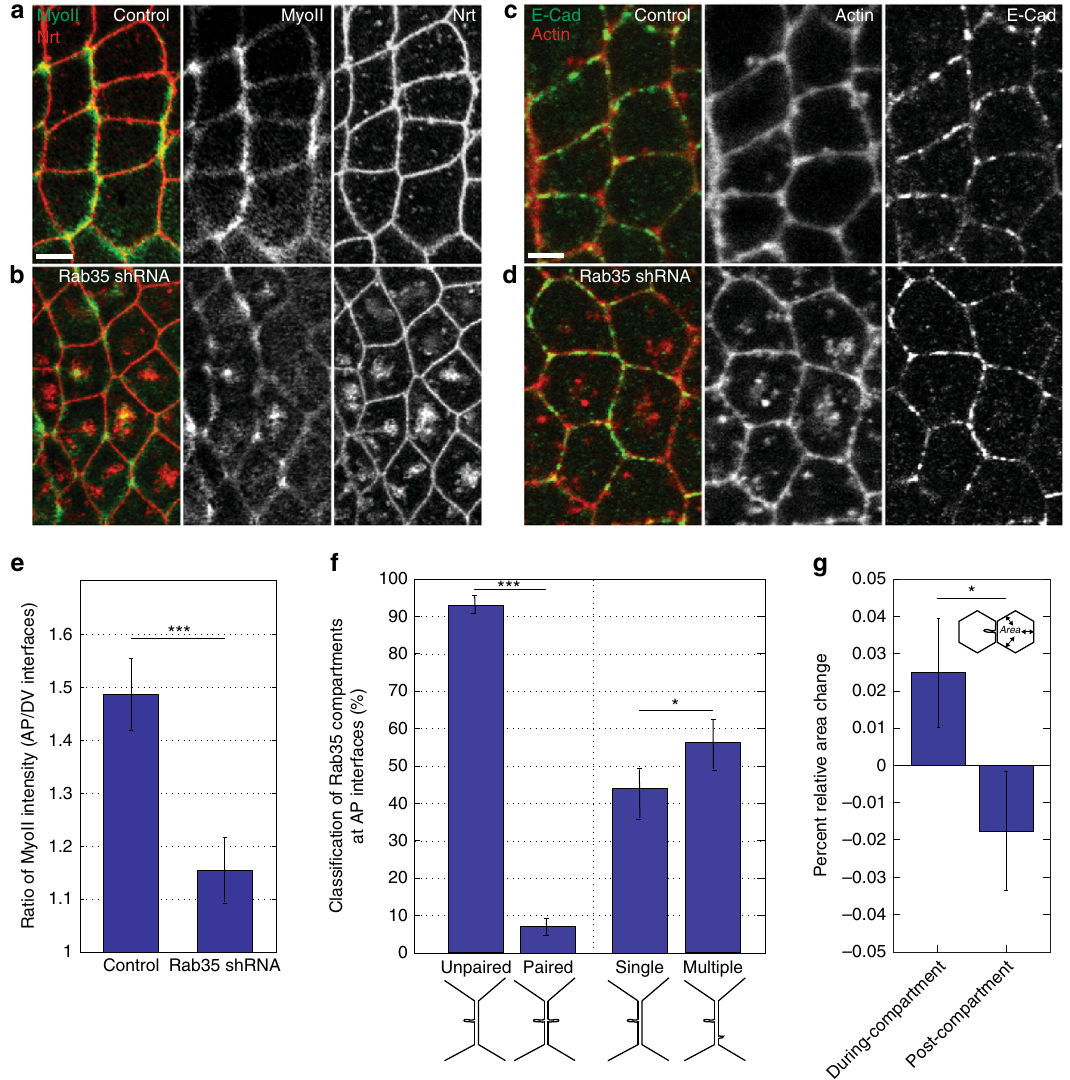
Fig. 7 Rab35 compartments demonstrate interfacial monopolarity and are essential for planar polarized junctional actomyosin networks. a – d Disruption of Rab35 function leads to cytoplasmic aggregation of a plasma membrane protein (anti-Nrt, red , a , b ), Myosin II (anti-Zipper, green , a , b ), and F-actin (phalloidin, red , c , d ). Anti-E-cadherin is in green ( c , d ). a , c Control (CRISPR:GFP:Rab35) or b , d Rab35-disrupted (CRISPR:GFP:Rab35; GFP shRNA) embryos. e Junctional Myosin II planar polarity is disrupted when Rab35 function is compromised (quanti fi cation of AP/DV junctional Myosin II ratios in CRISPR:GFP:Rab35 or CRISPR:GFP:Rab35; GFP shRNA-expressing embryos, n = 143 and 148 cells, respectively). f Rab35 compartmental behaviors suggest asymmetric force generation. Frequency of unpaired/paired and single/multiple compartments at single interfaces ( n = 200 interfaces). g Coupling of area oscillations and Rab35 compartment behaviors. Apical area contraction in the opposing cell occurs at the termination of a Rab35 compartment. Student ’ s t -test ( e , g ), Mann – Whitney U Test ( f ), * P < 0.05, ** P < 0.005, *** P < 0.0005. Error bars indicate standard error. Scale bars in a , c are 2.5